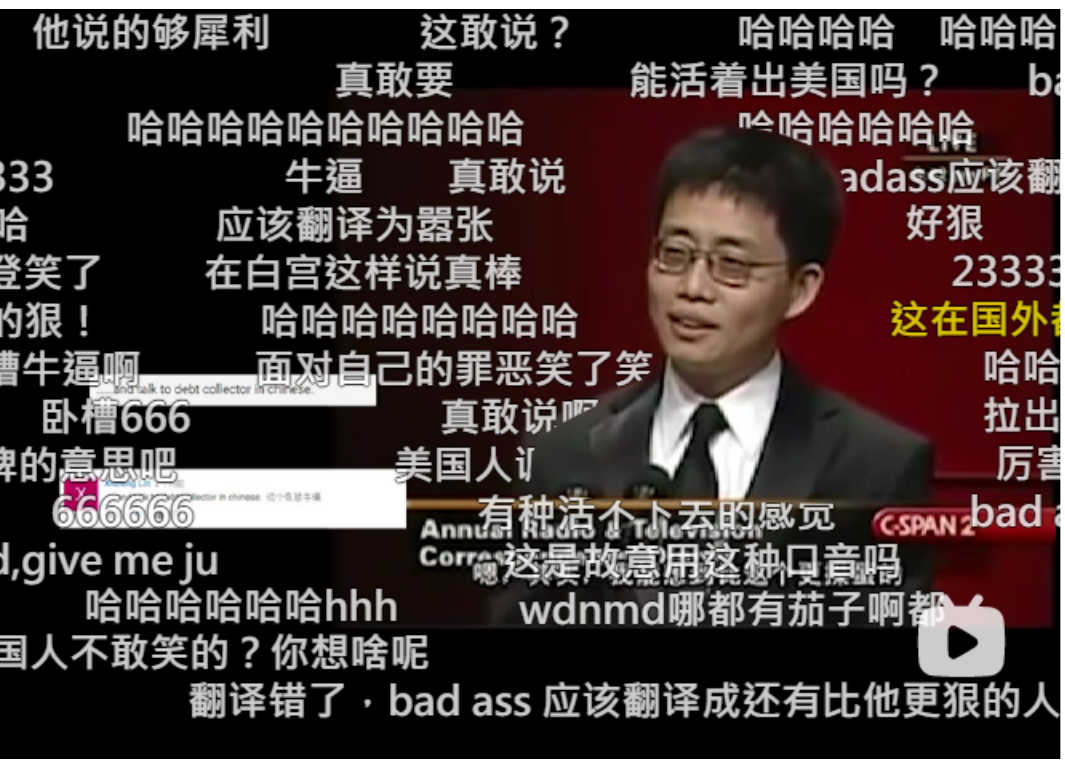
Figure 6. Badass instance. Danmu 1: 翻译错了， badass 应该翻译成还有比他更狠的人 Danmu 1 BT: The translation is wrong. Badass should refer to someone tough. Danmu 2: Badass 有厉害的意思 Danmu 2 BT: Badass can mean fierce.